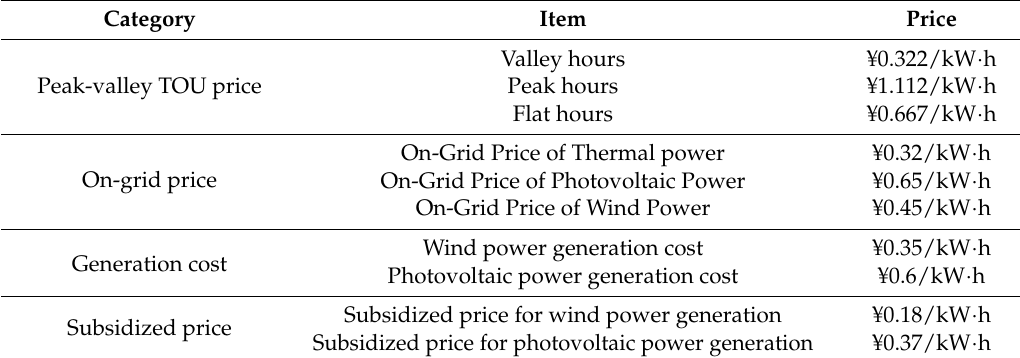
Table 4. Basic Data.